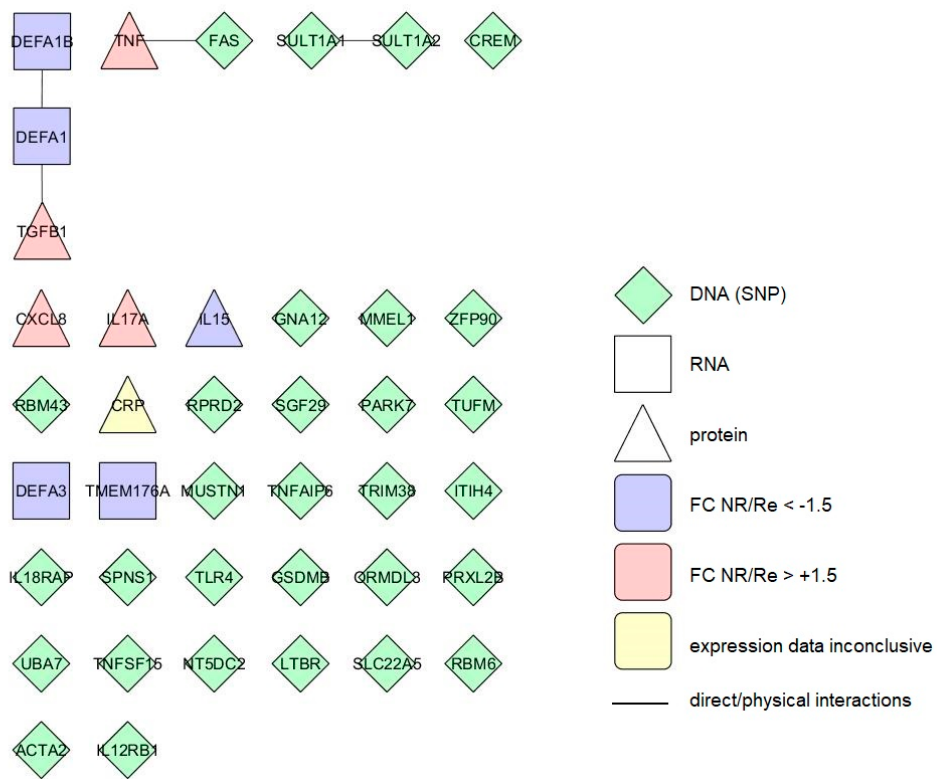
Figure 3. Interactome of the integrated blood markers linked to the short-term anti-TNF therapy response in CD patients. Different forms represent markers measured at different levels of expression. The colours represent differences in expression level (FC—fold change) between therapy nonresponders (NR) and responders (Re). Lines represent direct protein–protein interactions.